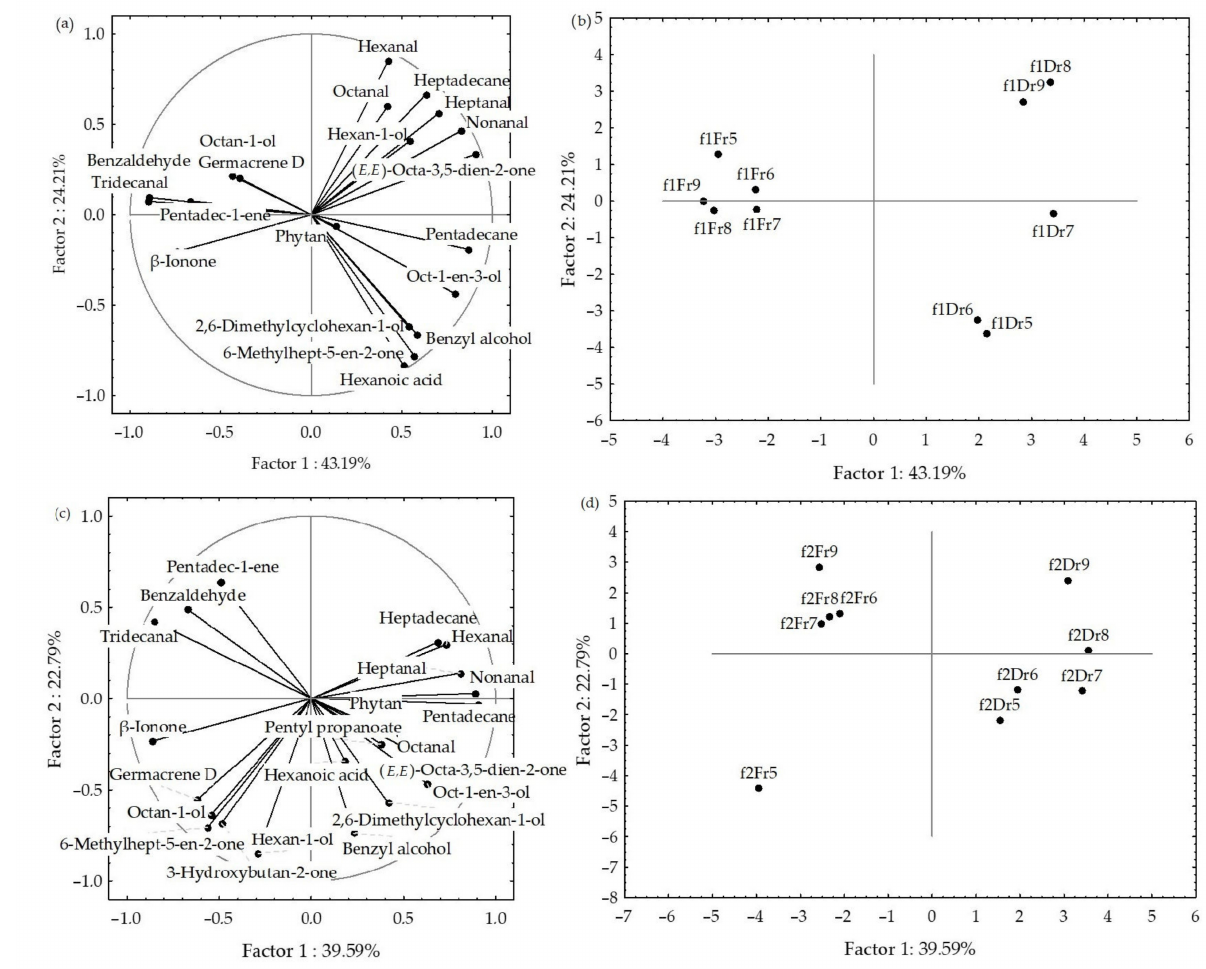
Figure 5. Correlation loadings ( a , c ) and score plots ( b , d ) of the dominant compounds from the headspace volatiles obtained by two different fibres for HS-SPME/GC–MS: divinylben- zene/carboxene/polydimethylsiloxane (f1) and polydimethylsiloxane/divinylbenzene (f2) of fresh (Fr, a , b ) and dried (Dr, c , d ) H. scoparia